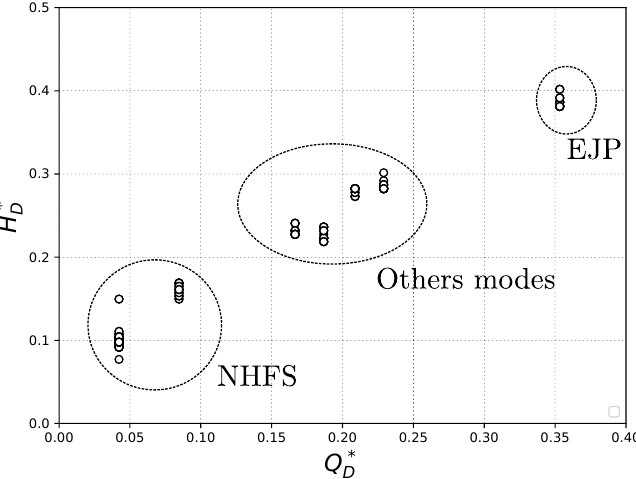
Figure 3. Normalized flow rate versus depth flow measured at the downstream conduit.